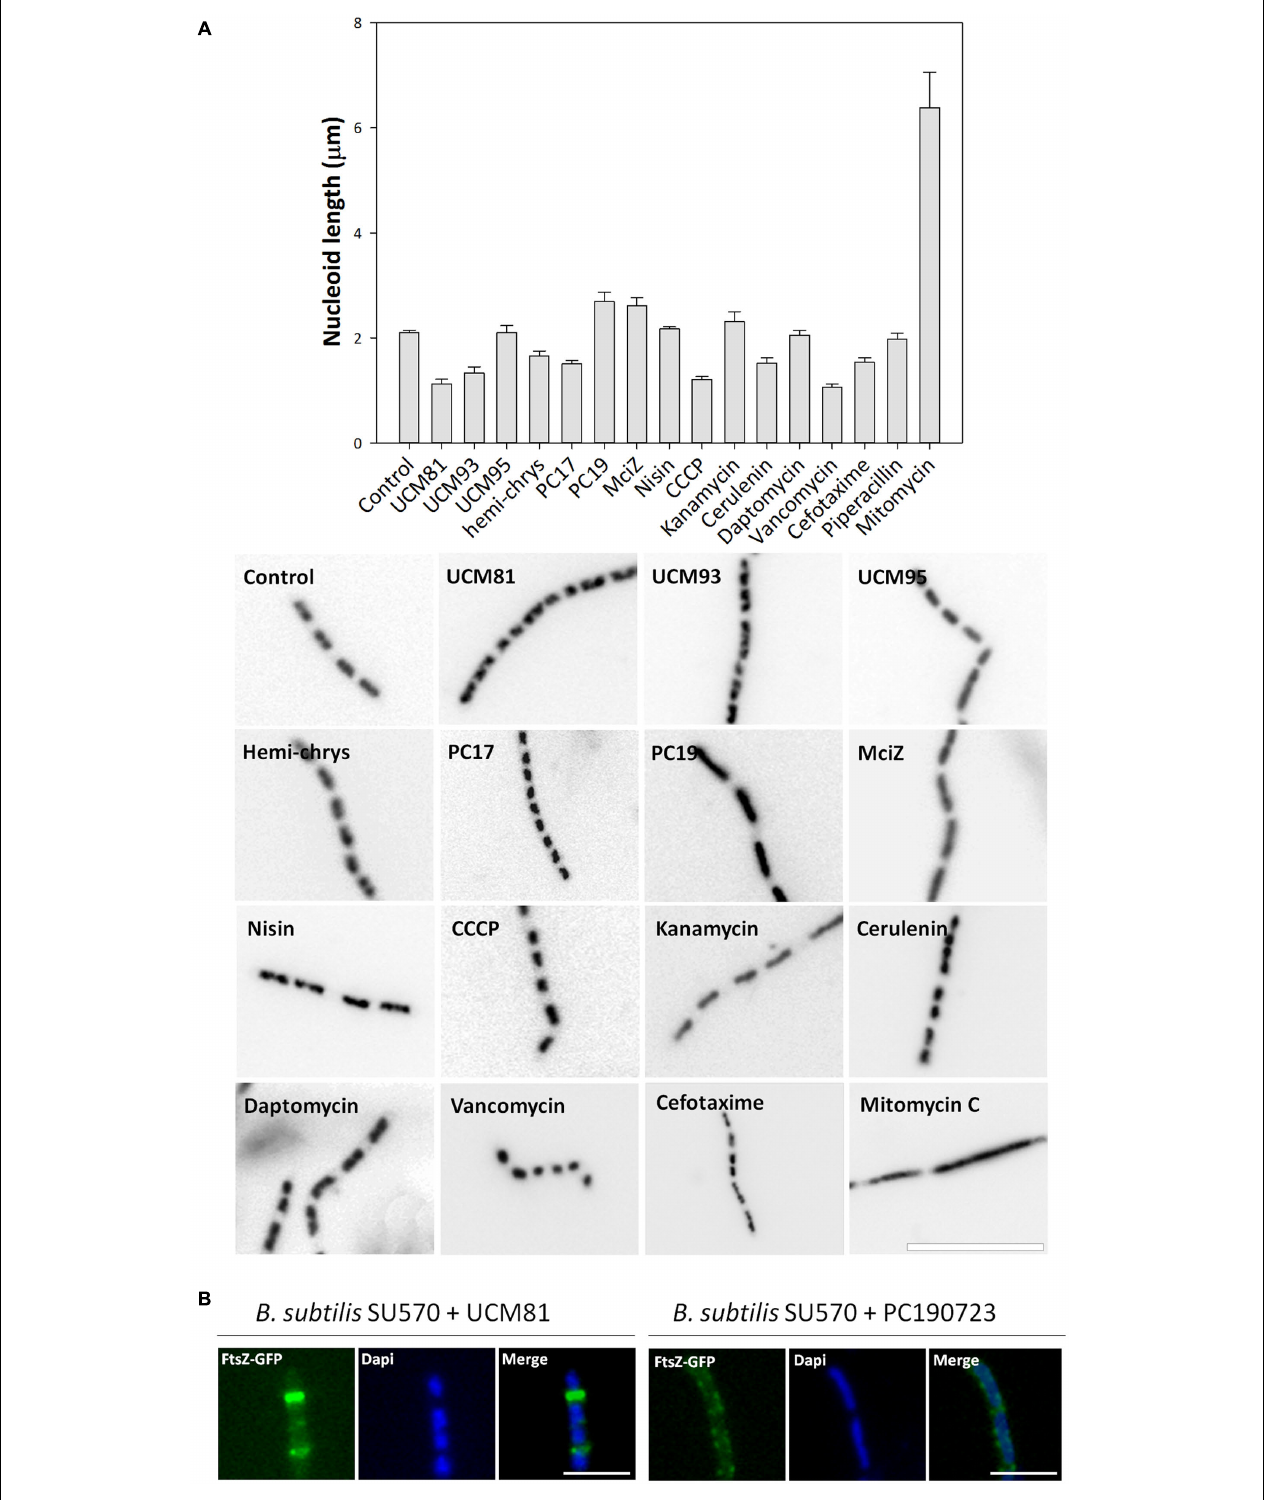
FIGURE 7 | Nucleoid morphology in cells treated with FtsZ inhibitors and others antibiotics. (A) B. subtilis 168 cells grown during 3 h in the presence or absence of compounds were stained with DAPI (1 µ g/mL) and analyzed under the microscope. Nucleoid length was measured (graphic; average and standard error are shown, n = 3). Scale bar: 10 µ m. (B) Detailed views of FtsZ-GFP and nucleoid morphology in B. subtilis SU570 cells grown during 1.5 hours in the presence of UCM81 or PC190723. Scale bar: 4 µ m.